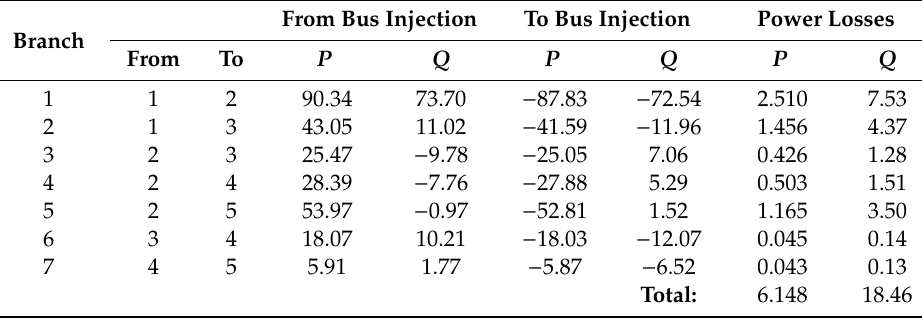
Table A14. Results of the mixed AC / DC PF calculations in Case 4. AC branch